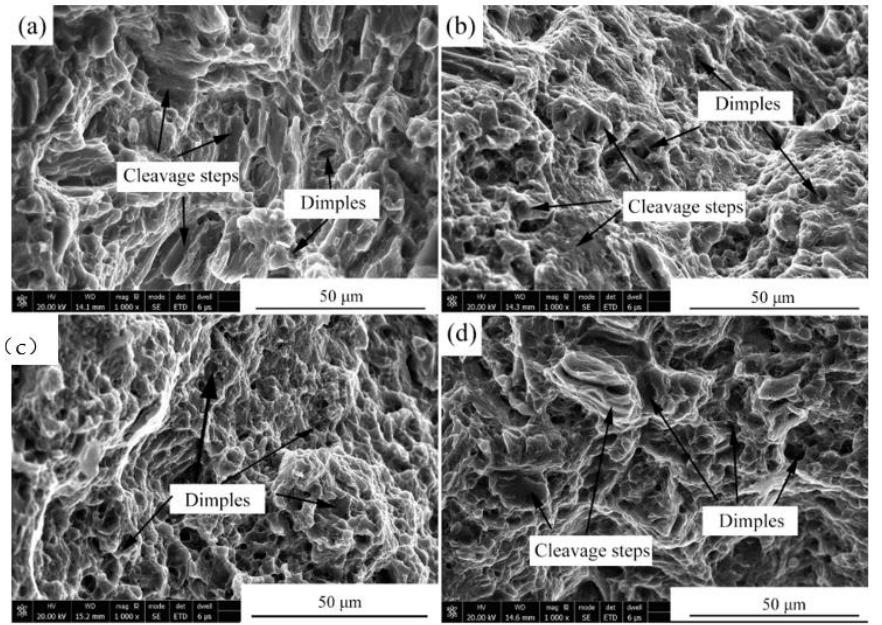
Figure 8. Fracture morphologies of the four-pass extrusion alloys: ( a ) Mg-2Zn-0.5Zr alloy; ( b ) Mg- 2Zn-0.5Gd-0.5Zr alloy; ( c ) Mg-2Zn-0.5Nd-0.5Zr alloy; and ( d ) Mg-2Zn-0.5Y-0.5Zr alloy.